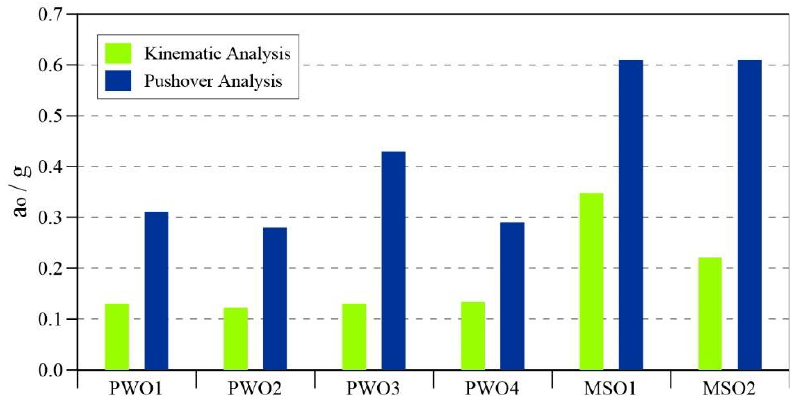
Figure 26. Comparison of the failure multipliers of kinematic and pushover analysis.